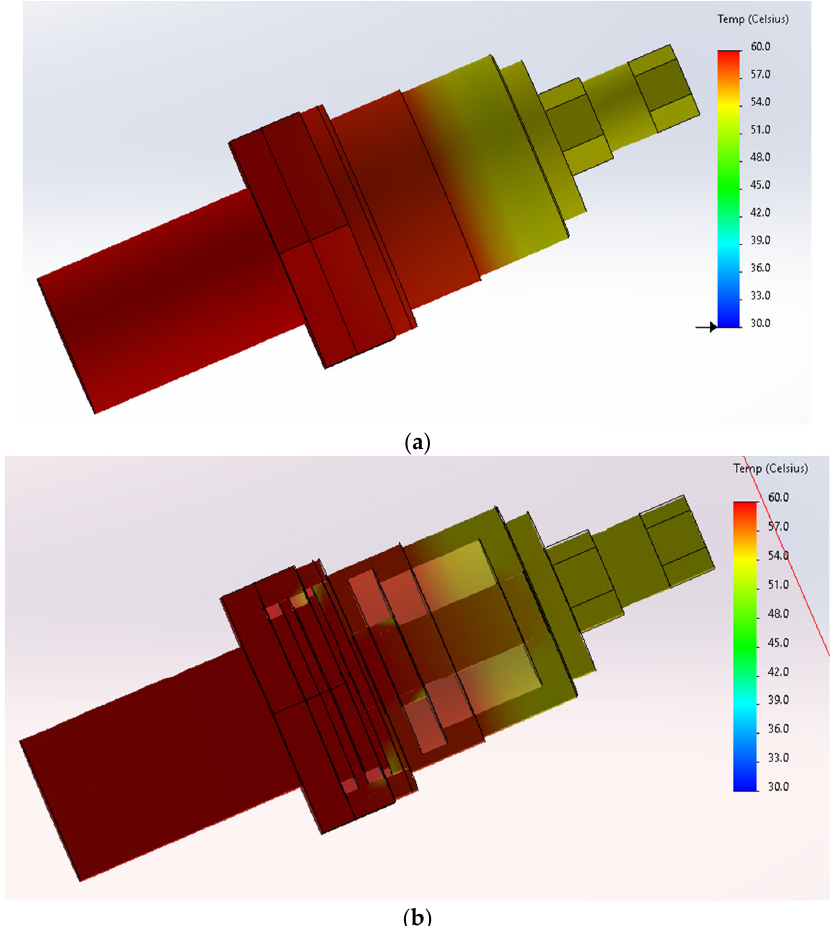
Figure 5. Temperature distribution on the case for P j = 9.91 W; ( a ) temperature distribution on the external surface of the case, ( b ) temperature distribution on the internal surfaces of the case.